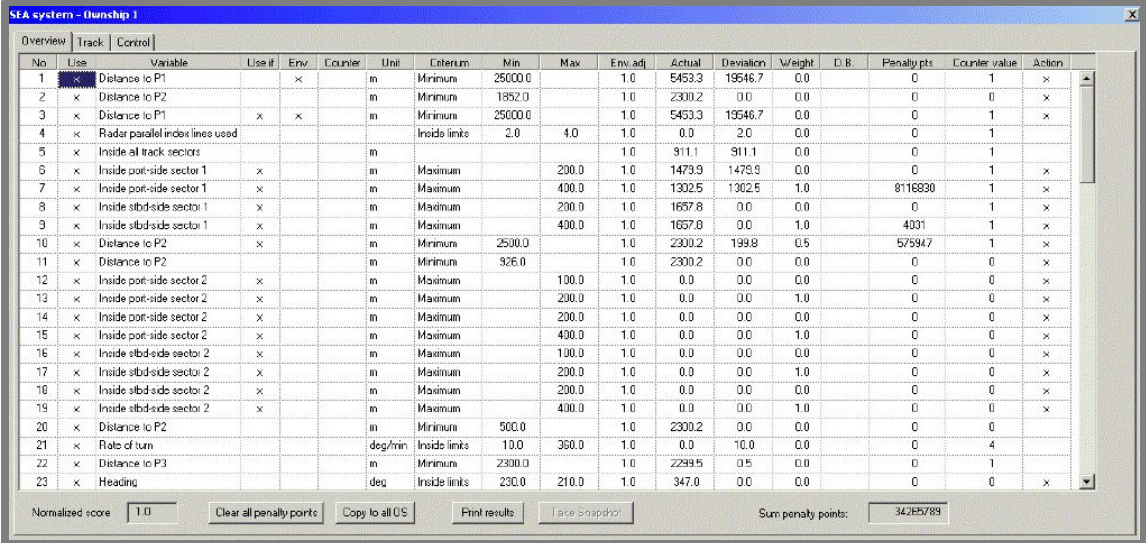
Figure 5. An example of an evaluation sheet generated in the SEA